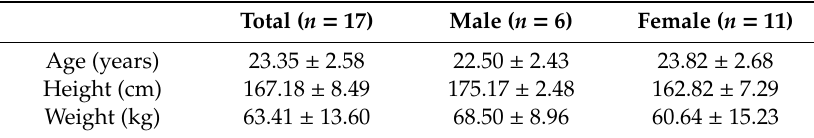
Table 1. Baseline characteristics of the participants.